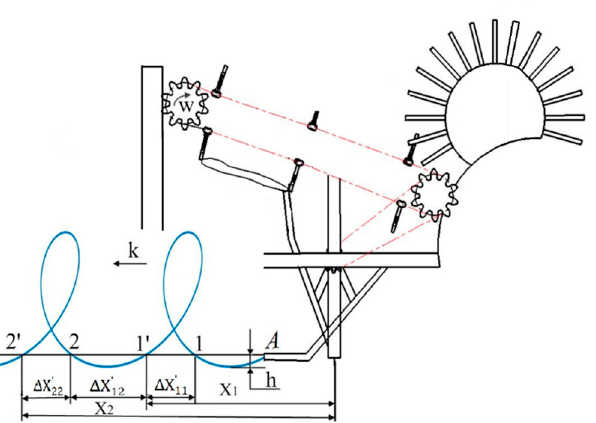
Figure 4. Schematic diagram of the stress of the finger in the adjacent period.